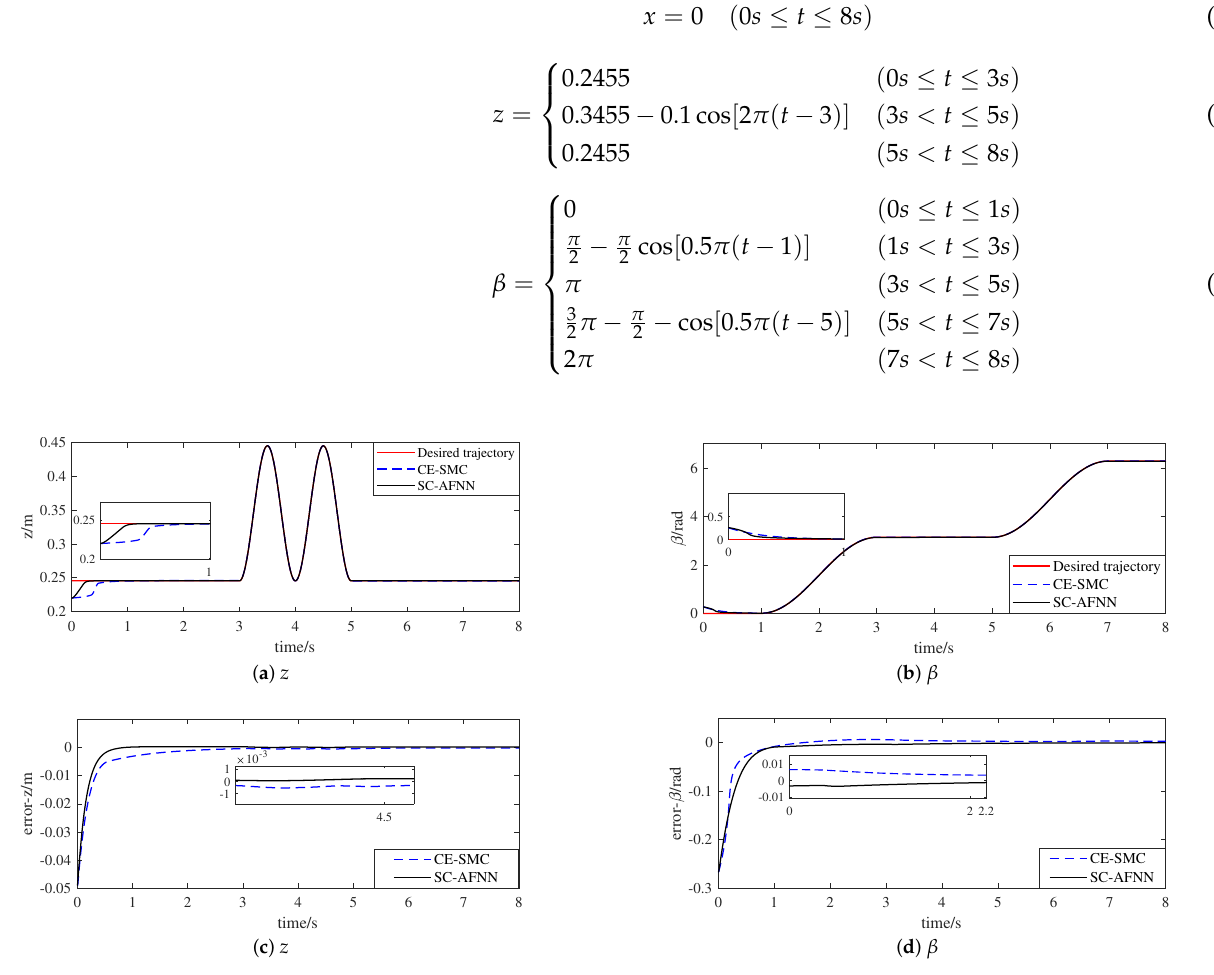
Figure 5. The tracking results of the UBSHR’s end-effector (desired trajectory 1). ( a ) z , ( b ) β , ( c ) error- z and ( d ) error- β . Table 1. The numerical values of the steady-state